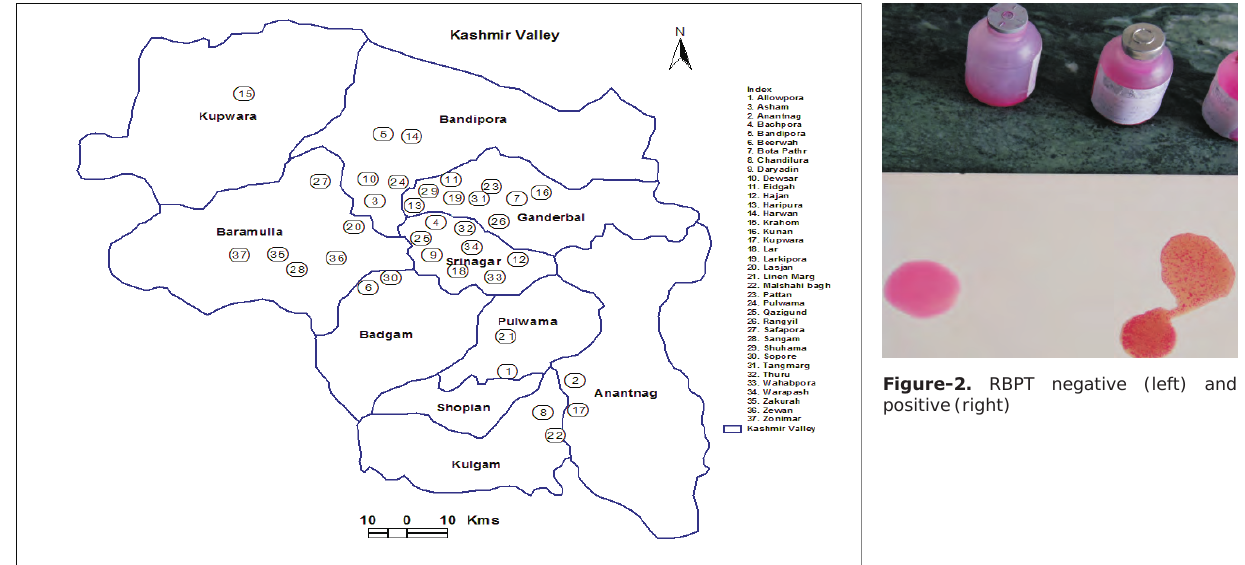
Figure-1. Map showing brucellosis affected areas of kashmir valley